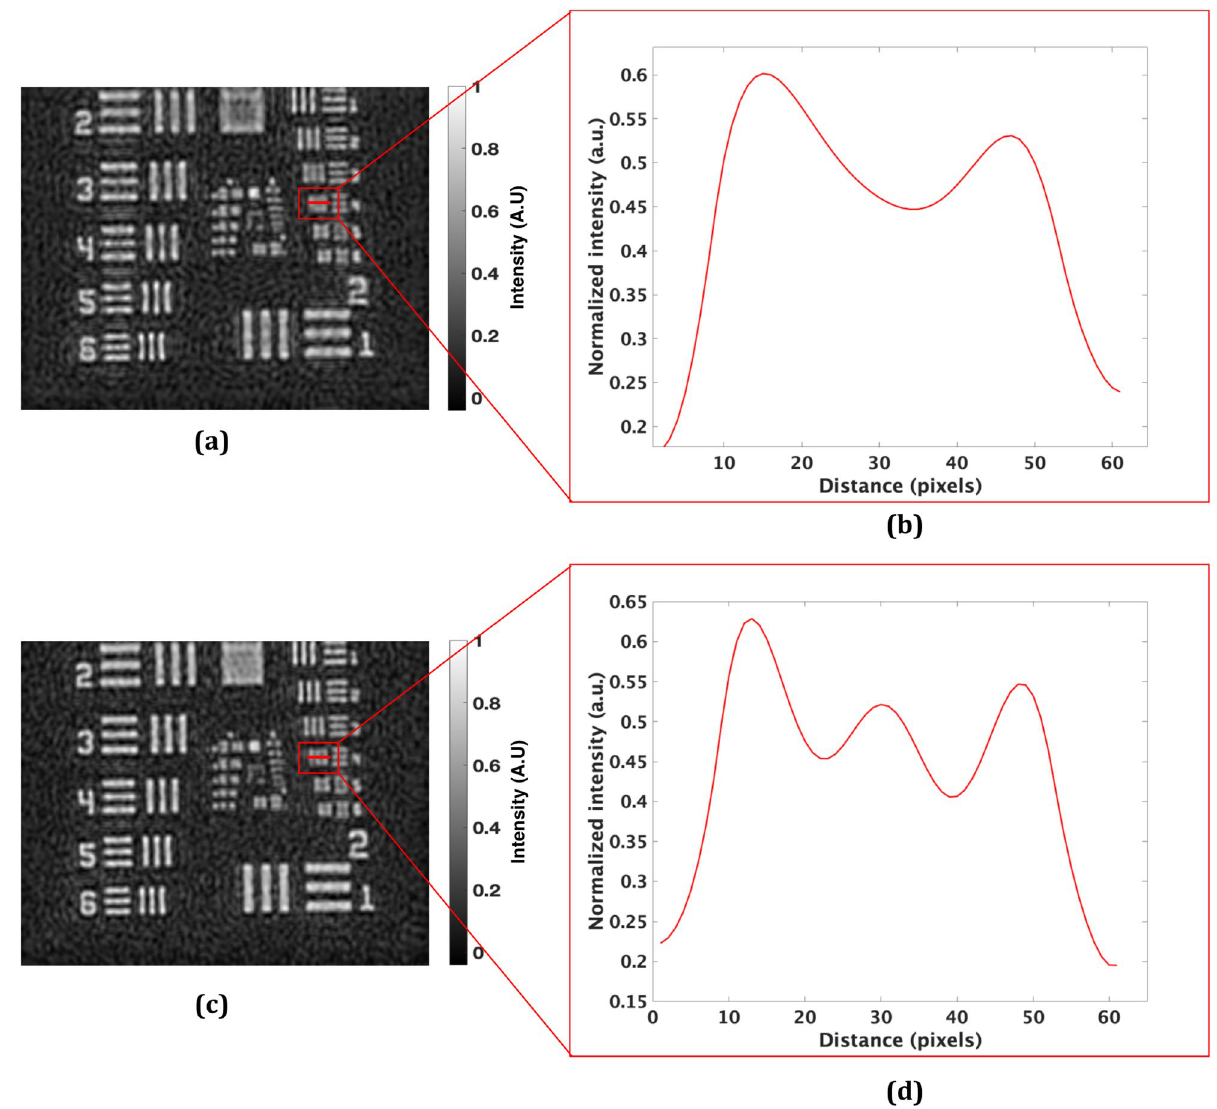
Figure 5. Amplitude reconstructed images of the Mech-Zehnder type DH system ( a ) without and ( c ) with grating; ( b ) and ( d ) corresponding normalized intensity profiles calculated along the red line shown in ( a ) and ( c